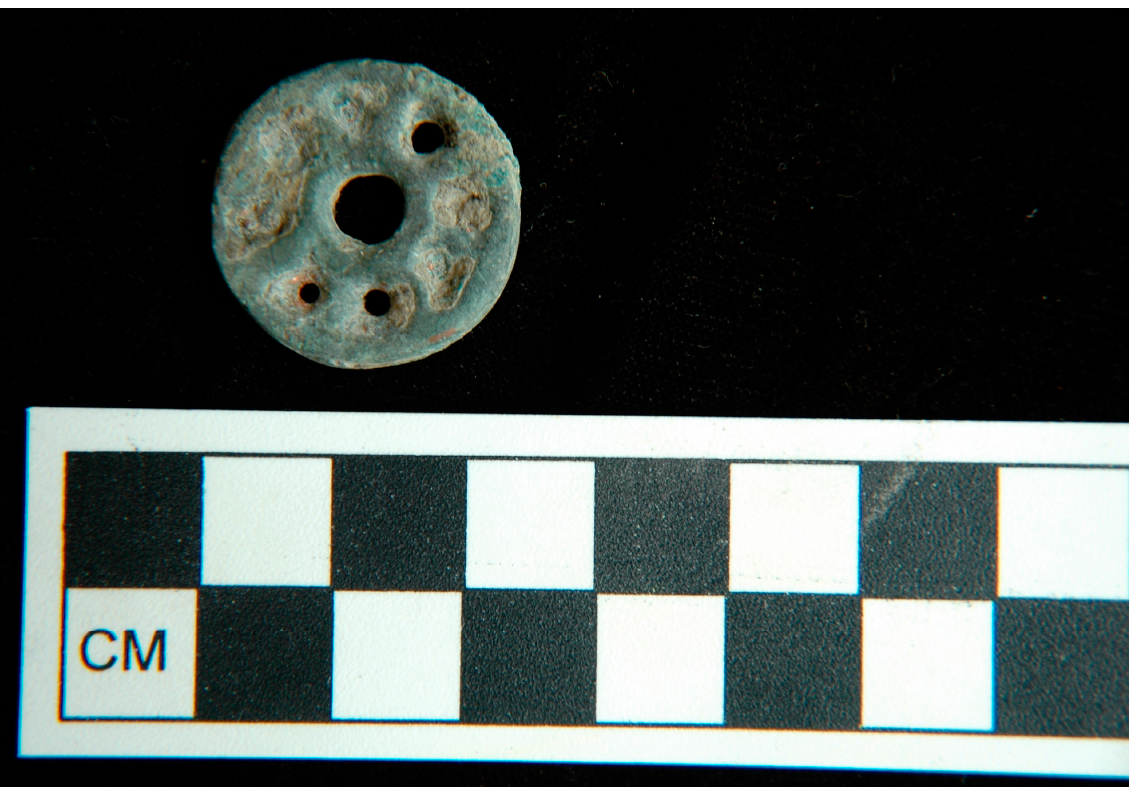
Figure 10. Bronze wheel from Taldy Bulak 2.